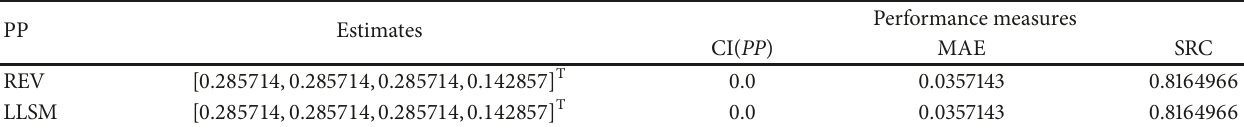
Table 1: Values of the PCM-CMs denoted as CI( PP ) for R ( x ) and proposed characteristics of PVs estimates ( ∗ ) quality in relation to the true PV for the case. PP